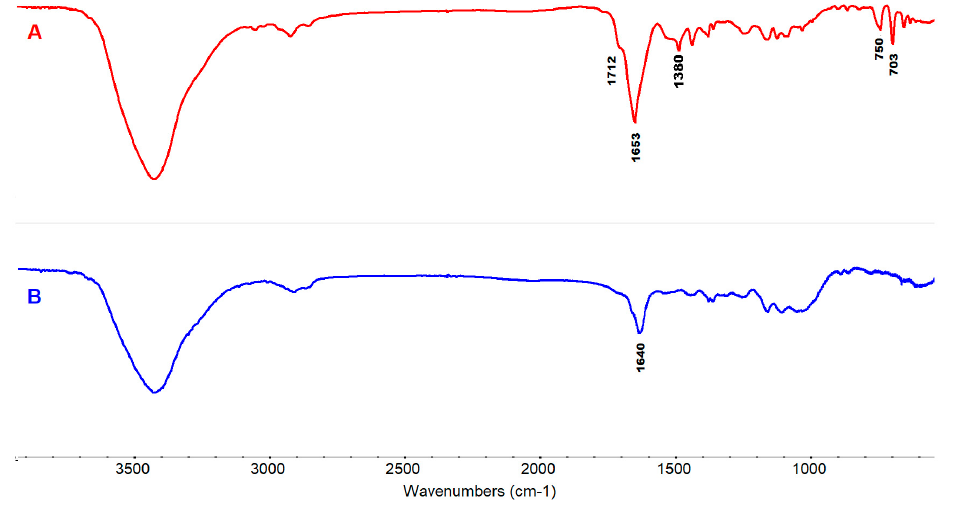
Figure 12. FT-IR spectra: ( Α ) of the protected PBLL 78 – b –(PLL 10 – g –P(Trt)HIS 15 ) block – graft polypeptide; and, ( B ) of fully deprotected PLL 78 – b –(PLL 10 – g –PHIS 15 ) block – graft